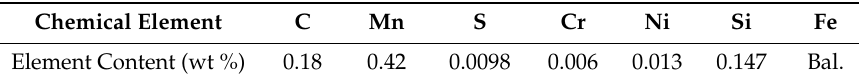
Table 1. Chemical component of Q345.